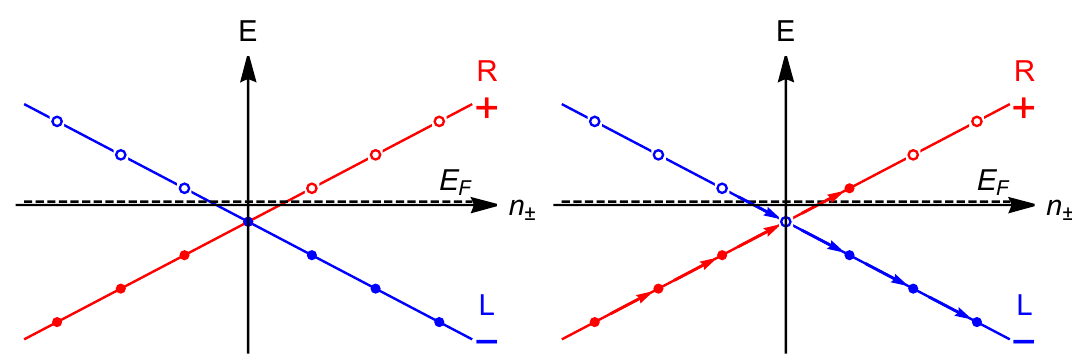
. Left panel: Ground F